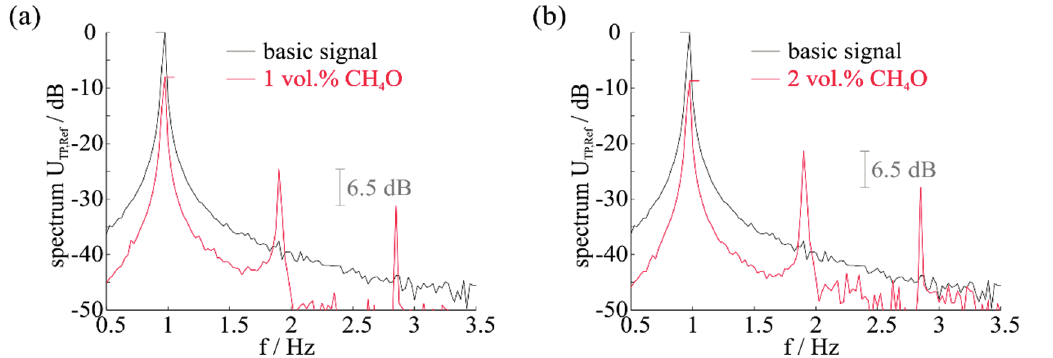
Figure 8. Spectrum at a gas concentration of ( a ) 1 vol.% CH 4 O and ( b ) 2 vol.% CH 4 O. The intensity of harmonics differs, while the distance (relation) is 6.5 dB in both